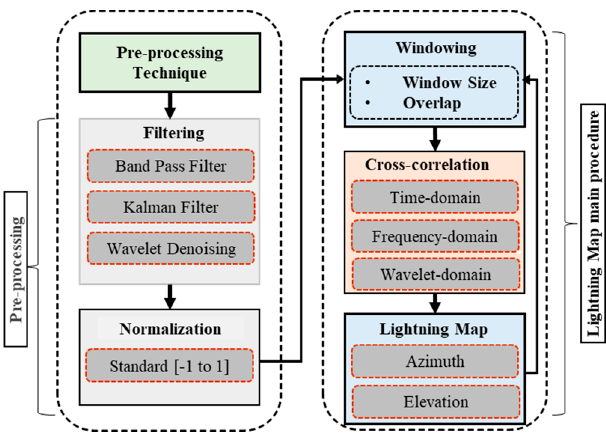
Figure 1. The procedure of lightning mapping.